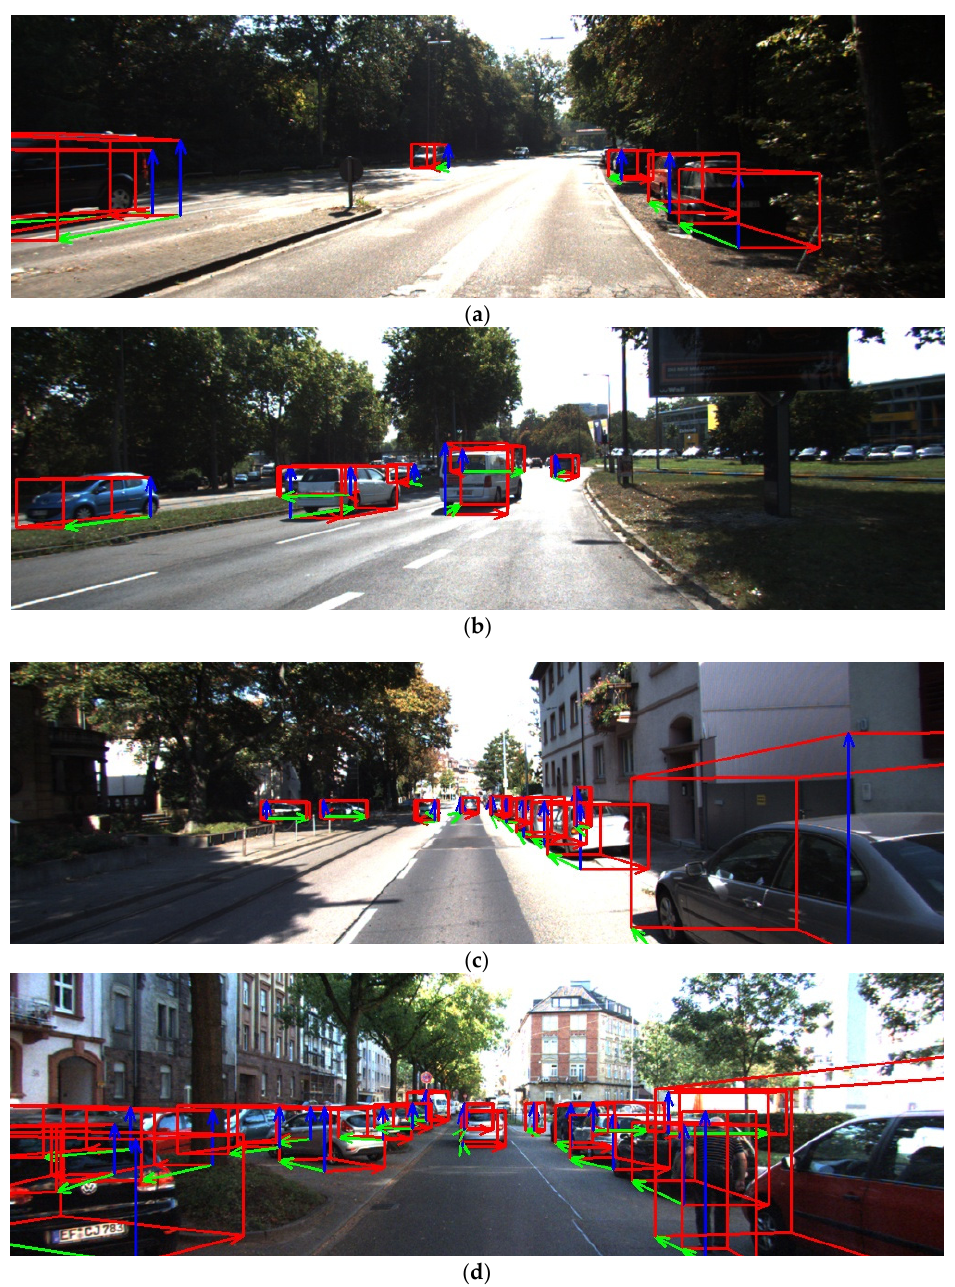
Figure 8. Visualization of attitude prediction by Q-net running on KITTI dataset. In Figure 8, the red arrow is the X -axis of the object ontology, the green arrow is the Y -axis of the object ontology, and the blue arrow is the Z -axis of the object ontology. It can be seen from the above figure that the pose determined by the XYZ three axis of the object conforms to the expectation of human vision for 3D scene understanding.